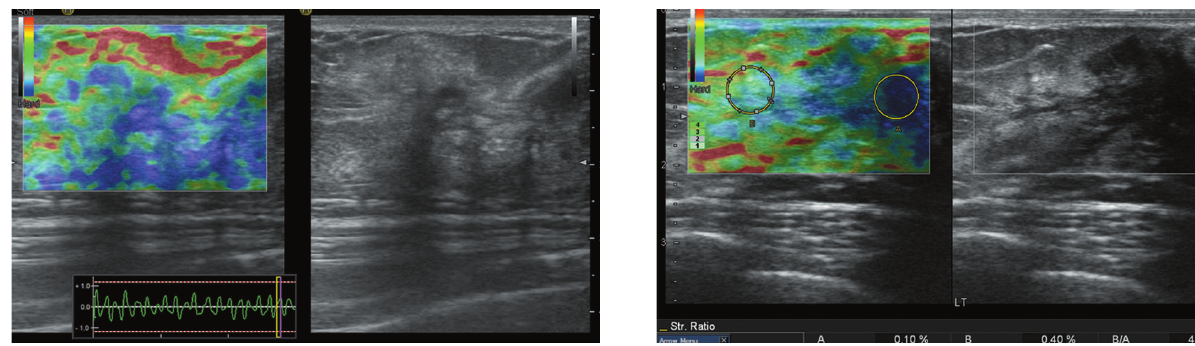
Figure 4: The strain ratio (the normal breast parenchyma versus the tumor) was more than